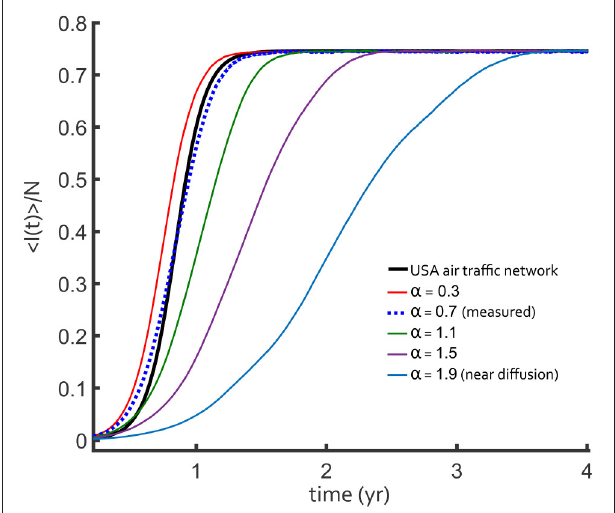
FIGURE 4 | Fraction of infected total population for a constant R 0 = 4, SIS influenza-like outbreak. The outbreak on the USA flight network (black curve) is compared to discretized fractional diffusion in one-dimension (colored curves). As the power law exponent α decreases, the transport becomes more superdiffusive and the dashed line is closer to the USA network result. The best-fit value of this exponent, α = 0.7 (blue dotted curve), is similar to the one measured in Figure 1A with D =